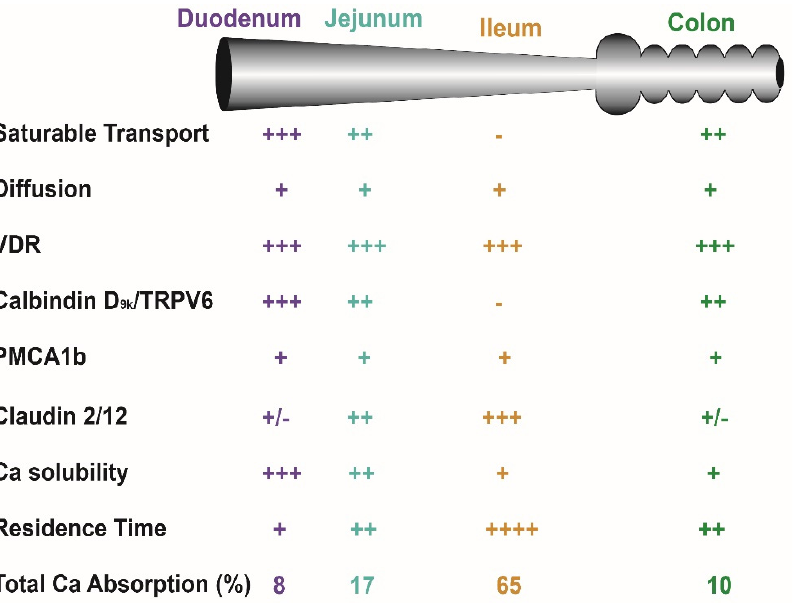
Figure 2. Critical factors that influence intestinal calcium (Ca) absorption. Many factors influence net Ca absorption and distinct Ca absorption mechanisms used in various intestinal segments. See Bronner and Pansu [38] for a discussion of solubility and transit time as factors affecting Ca absorption. The number of “+” signs reflects the magnitude of the parameter across tissues while a “-” sign indicates that the parameter is absent in a segment.